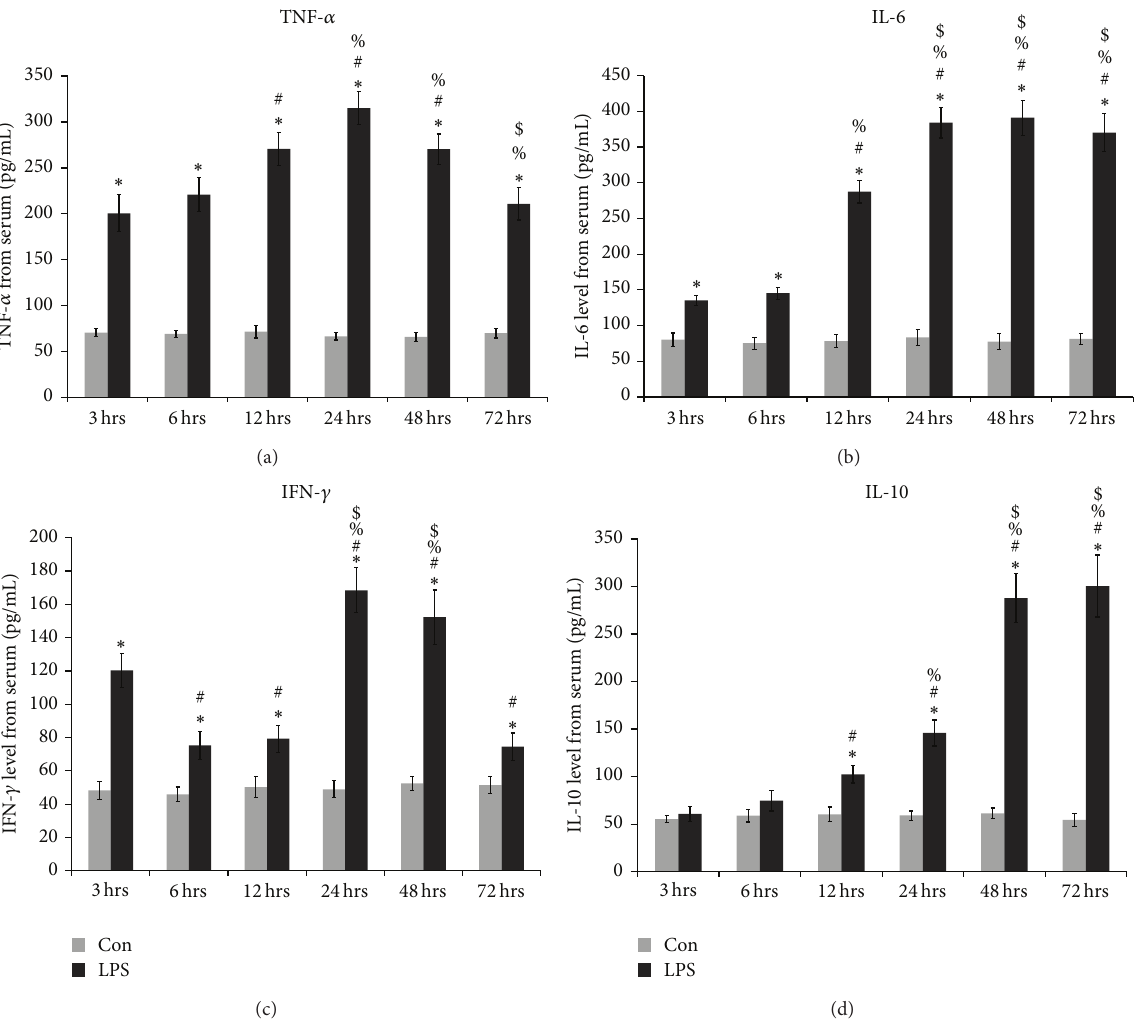
Figure 5: Serum cytokine levels in Swiss albino mice after experimental endotoxemia. Serum levels of (a) TNF- 𝛼 ; (b) IL-6; (c) IFN- 𝛾 ; and (d) IL-10 in control and LPS treated mice at 3, 6, 12, 24, 48, and 72 hours after treatment showed time-dependent variation with the onset of endotoxemia (values are expressed as Mean ± SD from triplicate experiments and are significant ( 𝑃 < 0.05 ) from 6 mice in each group). The following symbols represent the significant difference between: ∗ control versus LPS treated serum, # LPS treatment for 3 hours versus LPS treatment for 6, 12, 24, 48, and 72 hours, % LPS treatment for 6 hours versus LPS treatment for 12, 24, 48, and 72 hours, $ LPS treatment for 12 hours versus LPS treatment for 24, 48, and 72